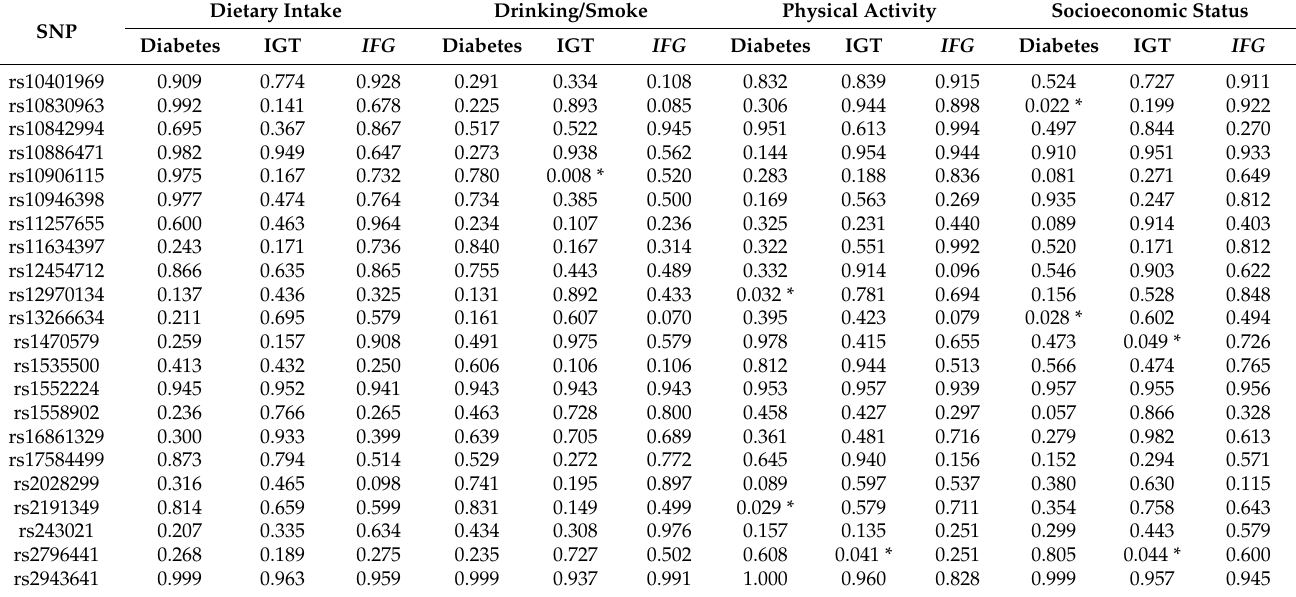
Table 4. The interaction between each factor and SNPs on T2D